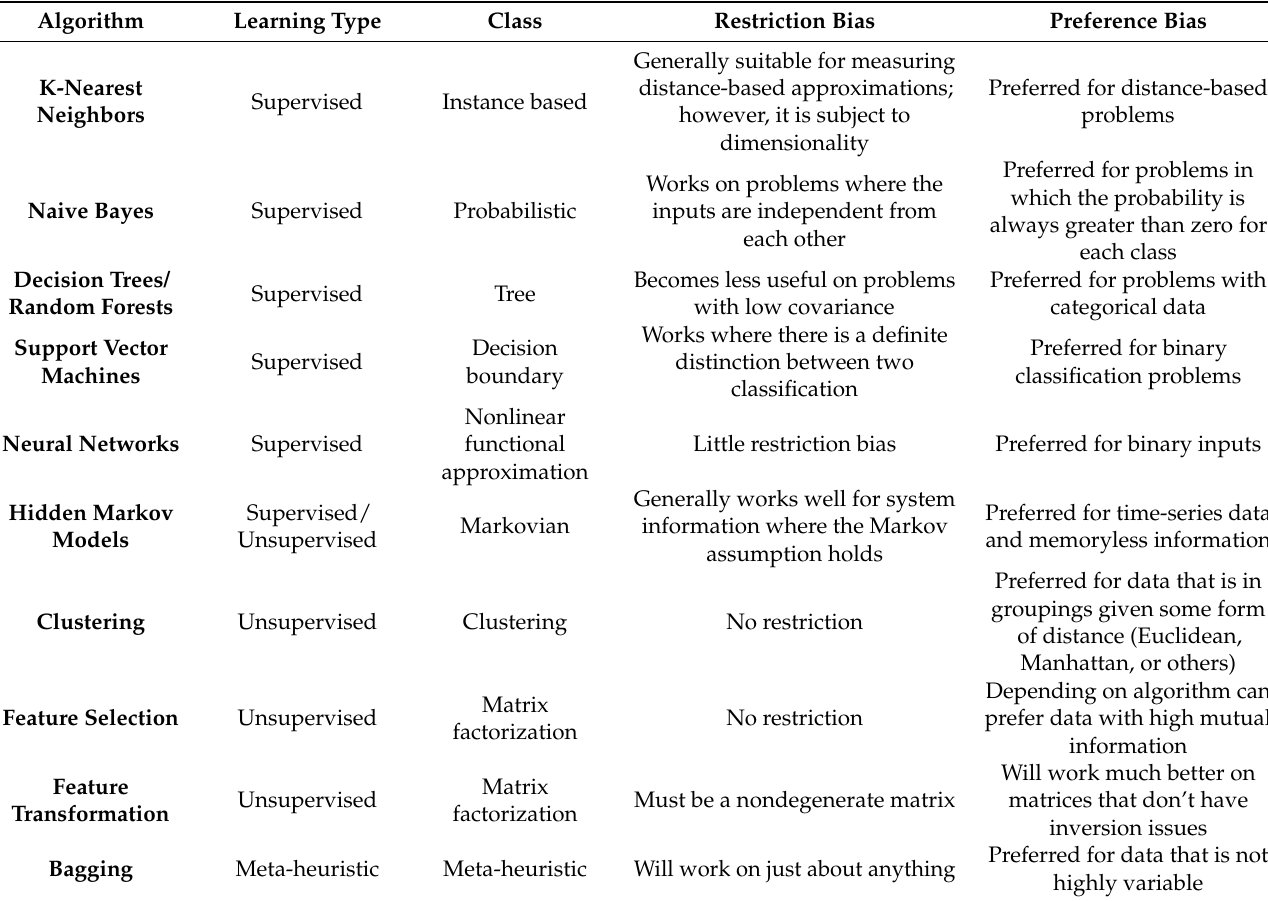
Table 1. Common machine learning